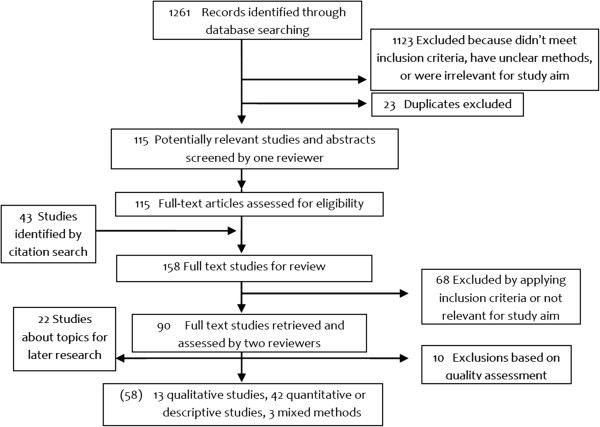
Flowchart of the systematic search.